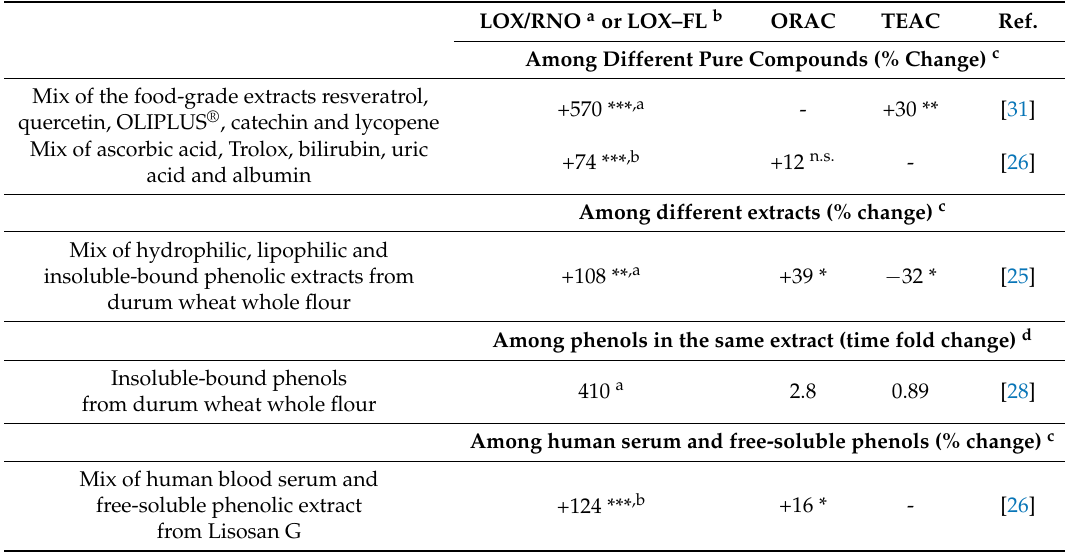
Table 4. Synergism among antioxidant compounds evaluated by LOX/RNO and LOX–FL methods in comparison with ORAC and TEAC